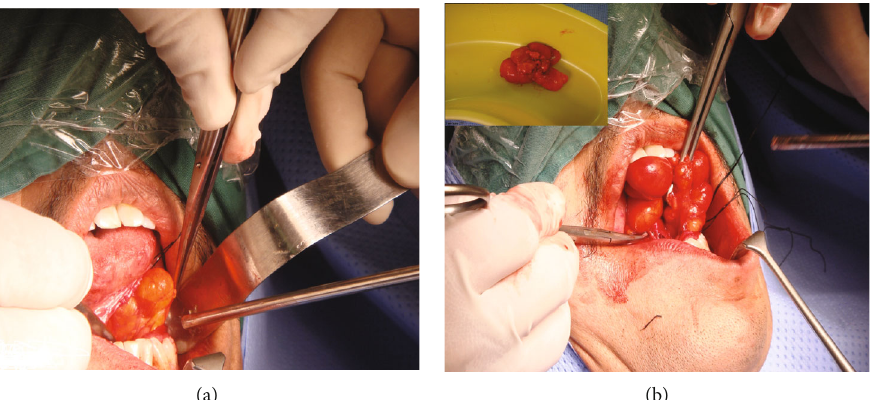
Figure 2: (a, b) Surgical excision of the intraoral mass. Mass was yellowish, soft, and irregular in shape. Inset in (b) is the whole mass after excision.